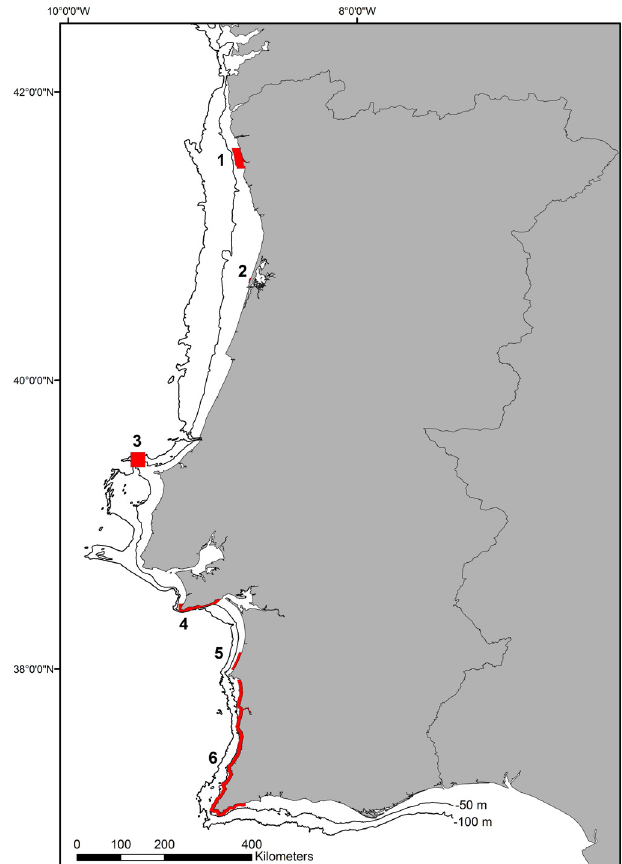
Fig. 1. Map of the study area showing the six existing MPAs (in red: 1-Litoral Norte, 2-Reserva Natural Duna São Jacinto, 3- Reserva Natural Lagoa Sto André, 4-Berlengas, 5- Arrábida, 6-Parque Natural Sudoeste Alentejano e Costa Vicentina) and the 50 and 100 m depth